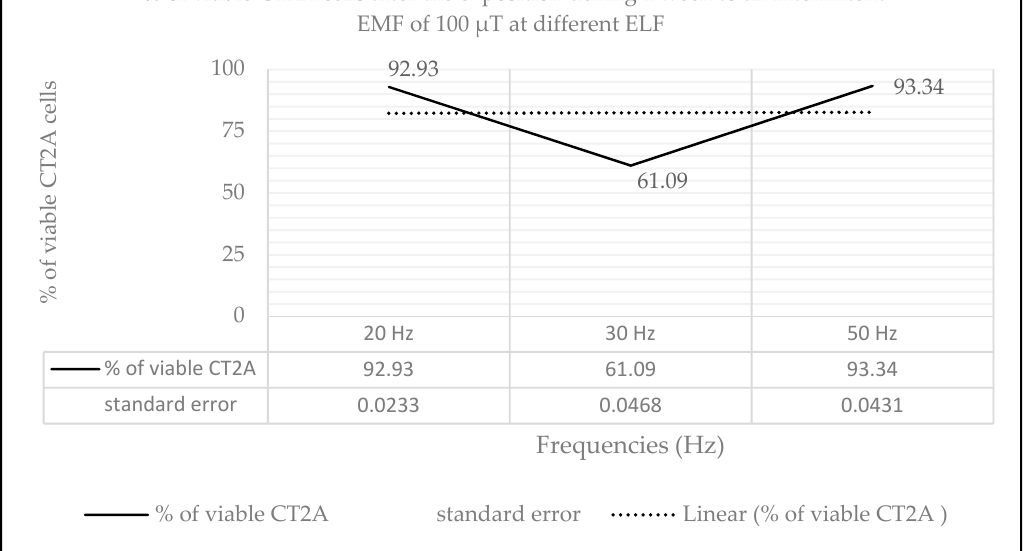
Figure 2. Graphical representation of % of viable CT2A cells after the exposure during seven days to an intermittent EMF of 100 μ T at different ELFs: 20, 30, and 50 Hz.